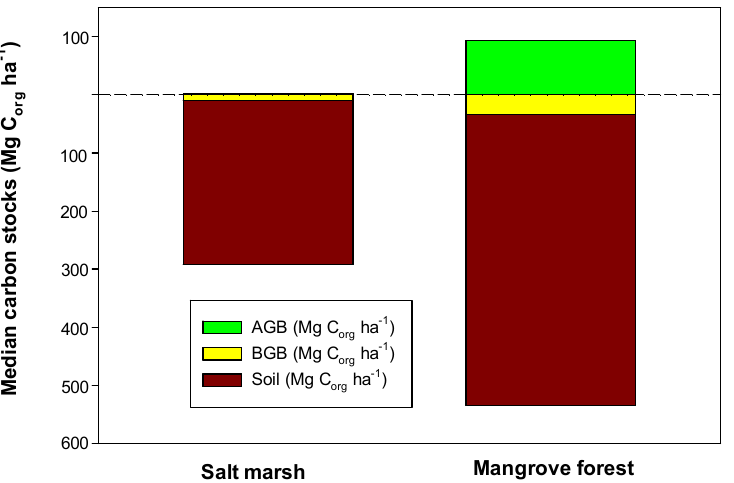
Figure 1. Median organic carbon stocks vested in above- and belowground plant biomass and in soils to a depth of 1 m in salt marshes and mangrove forests on a per hectare basis. Mean (±1 standard error) values and references are listed in Table 1.